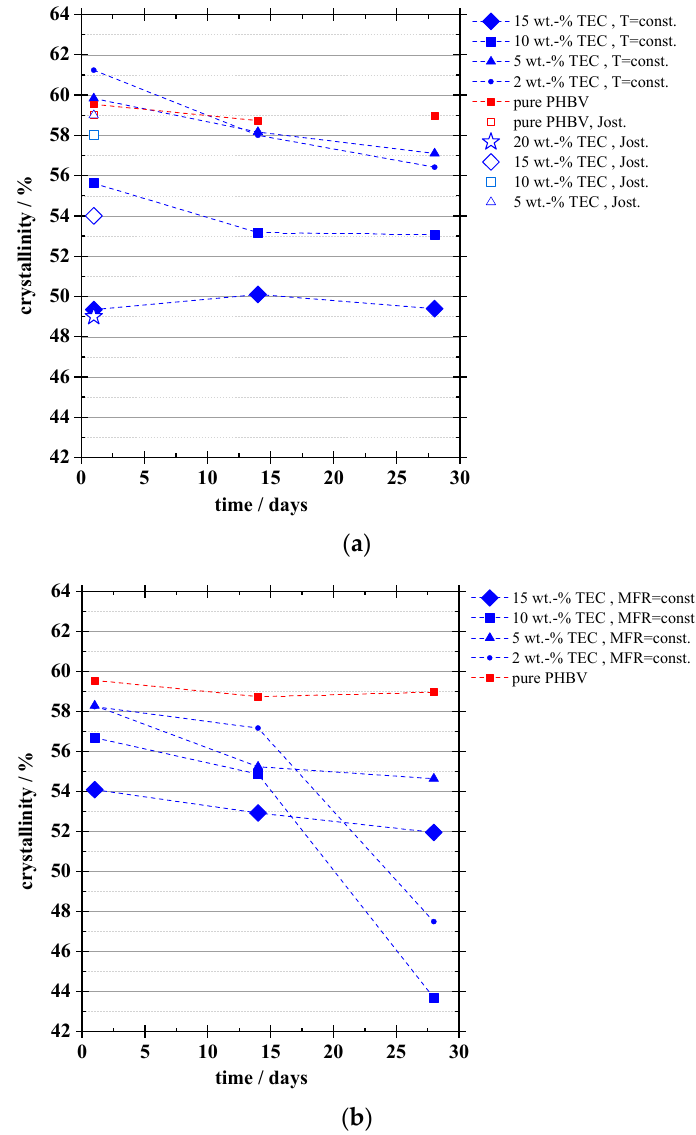
Figure 3. Crystallinity as function of time of PHBV layers blended with TEC: ( a ) temperature (T) during extrusion constant; ( b ) melt flow rate (MFR) during extrusion constant.